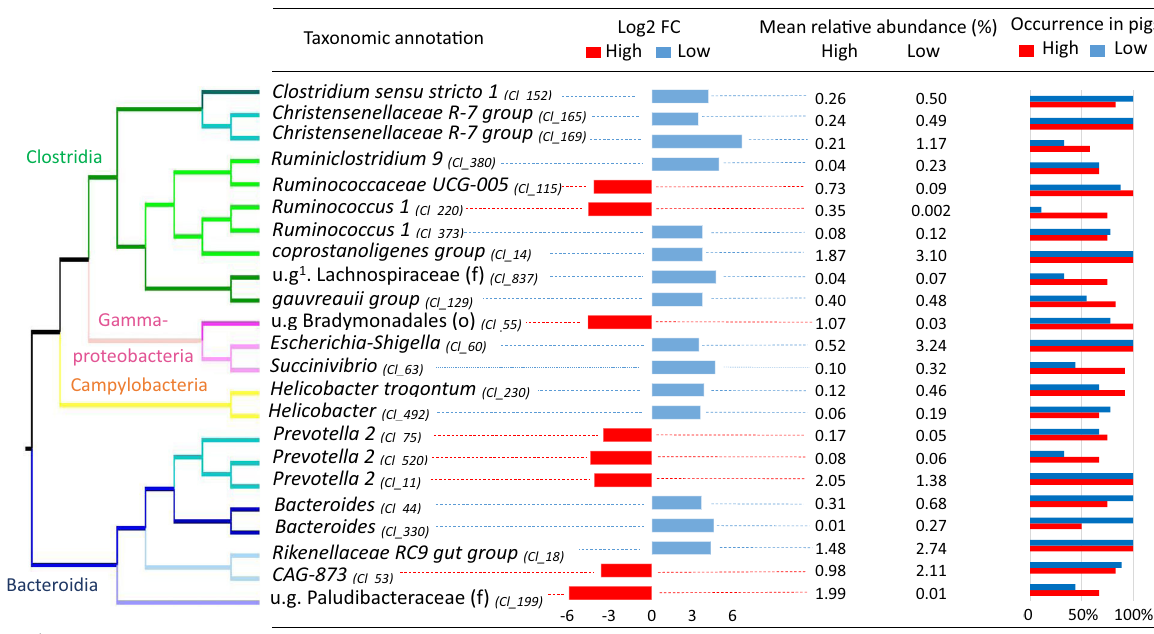
Fig. 4 Summary of taxonomic annotation and quantitative analysis of the 23 OTUs that were differentially abundant in the D28 fecal microbiota of pigs that demonstrated extreme IAV-speci fi c IgG responses at D63. OTUs are ordered according to their phylogeny. Taxonomic classi fi cation is indicated at the genus level except for two OTUs annotated at the levels of family (f) and order (o). The cluster identi fi er for each OTU is indicated in parentheses after the taxonomic annotation. The Log2 fold change (Log2 FC) between high (red) and low (blue) responders is represented by horizontal histograms together with the mean relative abundance, in percentage (%), per group. The respective occurrence of each OTU in high (red) and low (blue) responder groups is indicated on the right hand of the fi gure and indicates the percentage of individuals per group that contained that OTU. All data are available in Supplementary Data 6.